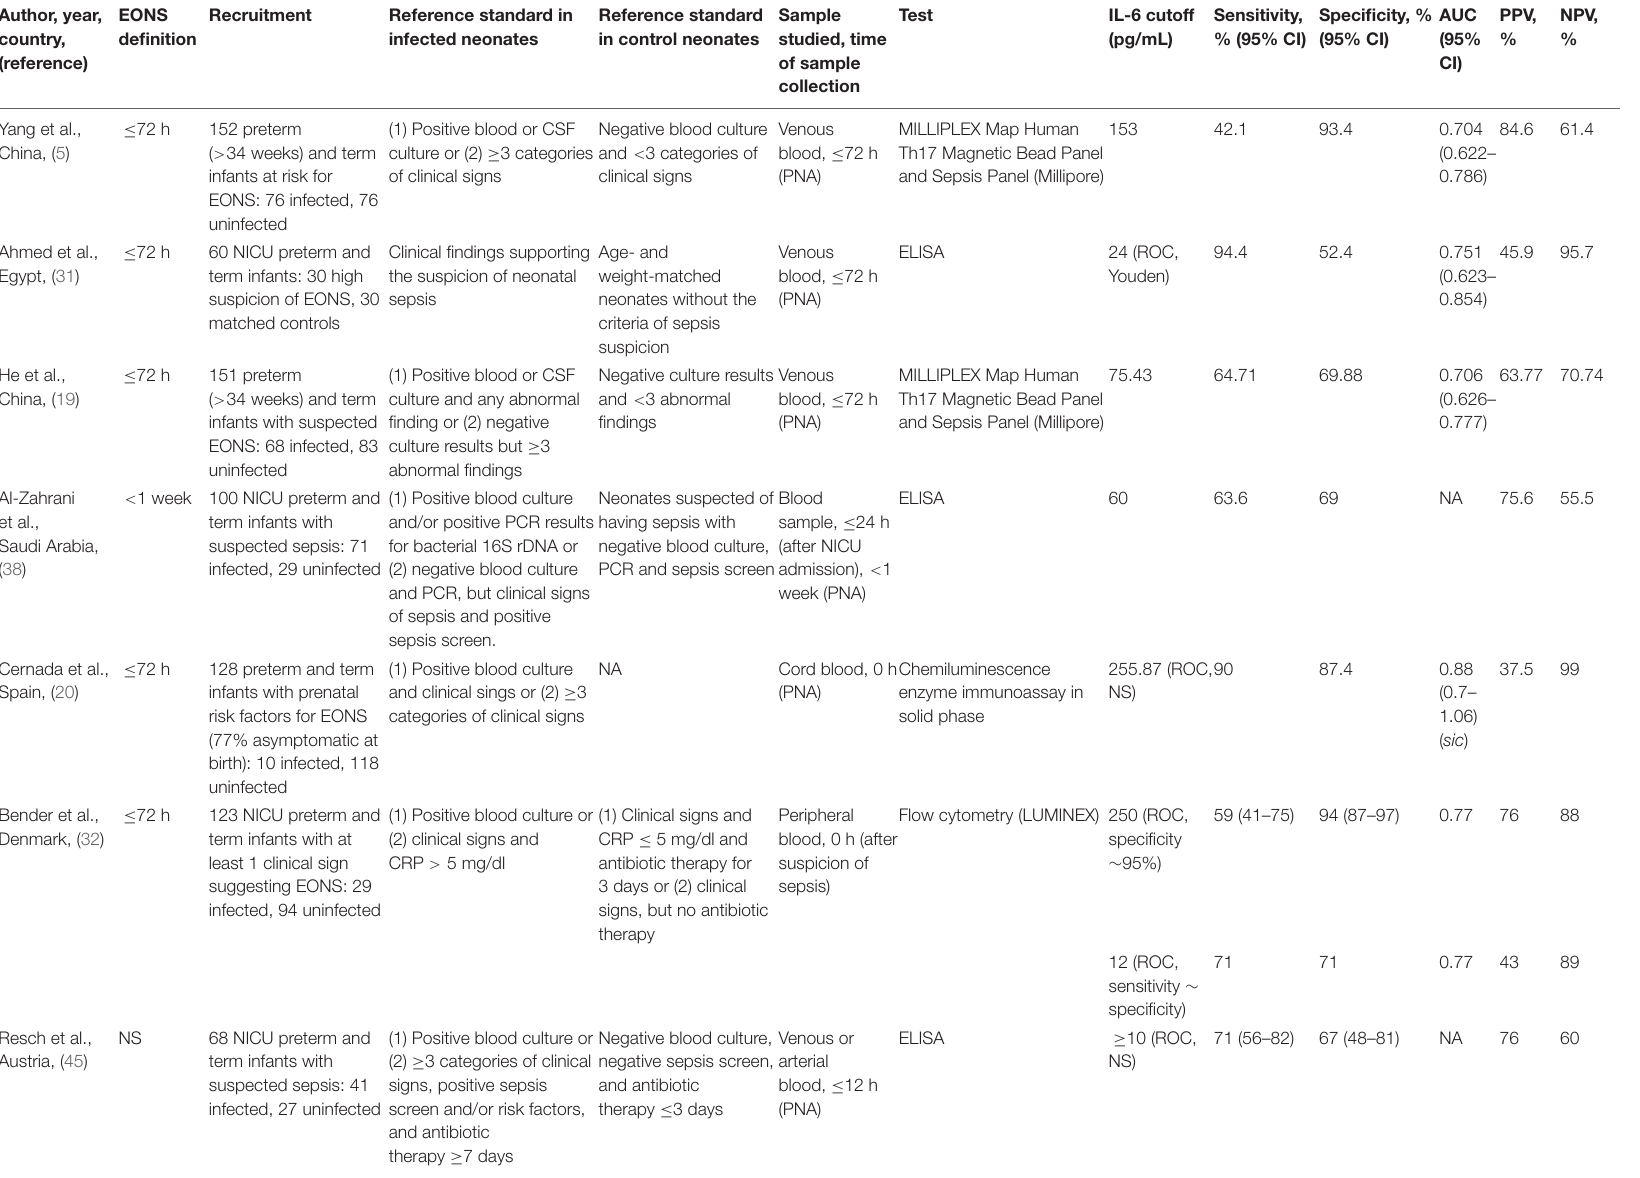
TABLE 2 | Characteristics of IL-6 accuracy studies for diagnosing EONS in a mixed population of preterm and term infants. Author, year,